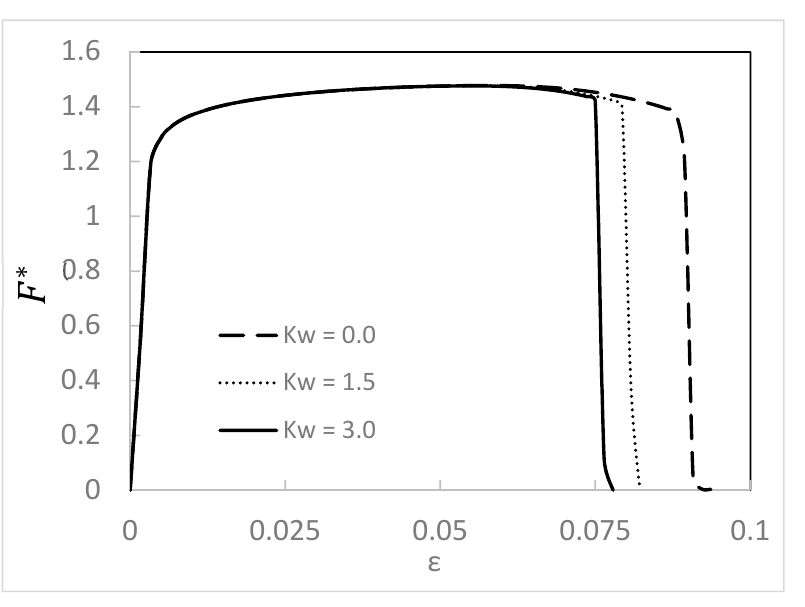
Figure 5. Effect of 𝑘 𝑤 on the normalized force–tensile strain curve.